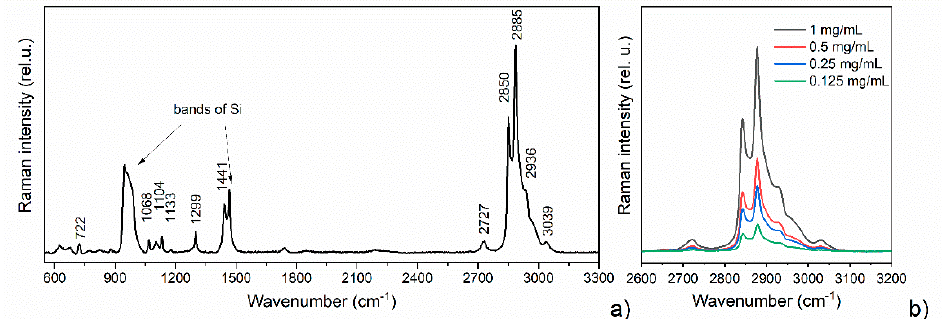
Figure 6. DCDRS spectra of dried liposome suspension from ring-shaped pattern on smooth pPTFE substrate ( a ) at DPPC concentration of 1 mg/mL in the spectral interval 550–3300 cm − 1 . Marked bands of Si originate from the base layer of the substrate; and ( b ) comparison for the upper dominant region at four different concentrations.